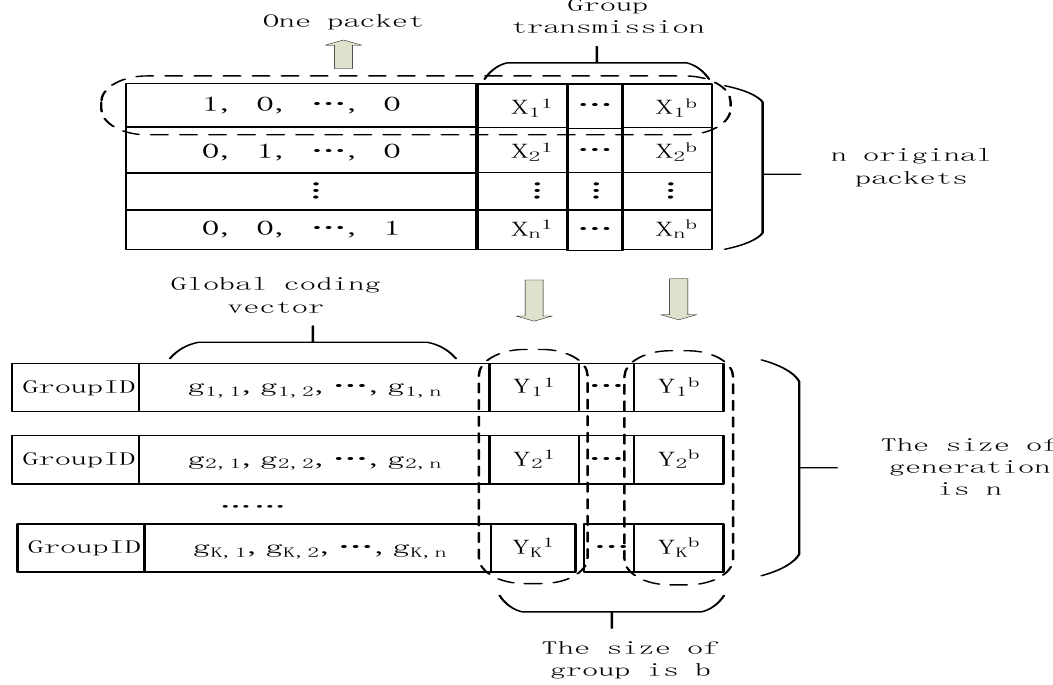
Figure 3. The packet format of practical network